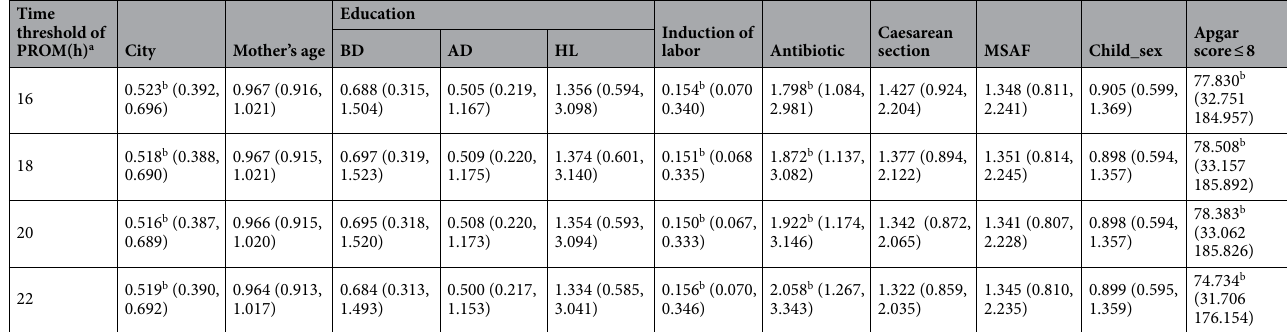
Table 6. Adjusted OR of other factors at time thresholds with significant differences of EOP in 7 days according to length of time of PROM. a Length of time of ruptured membranes from 0 h through specific time threshold. b P <